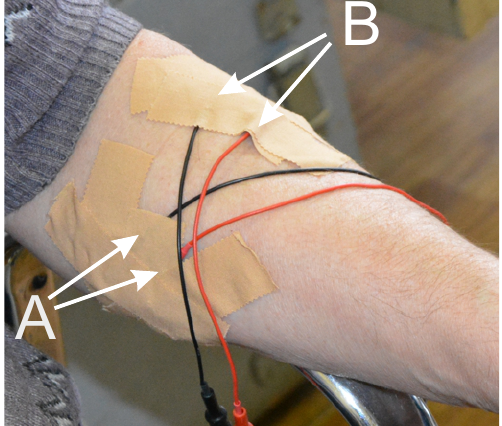
Figure 2. The location of the EMG electrodes on the patient’s arm. A—a bipolar electrode on the flexor muscle musculus flexor carpi radialis. B—a bipolar electrode on the extensor muscle musculus extensor carpi radialis